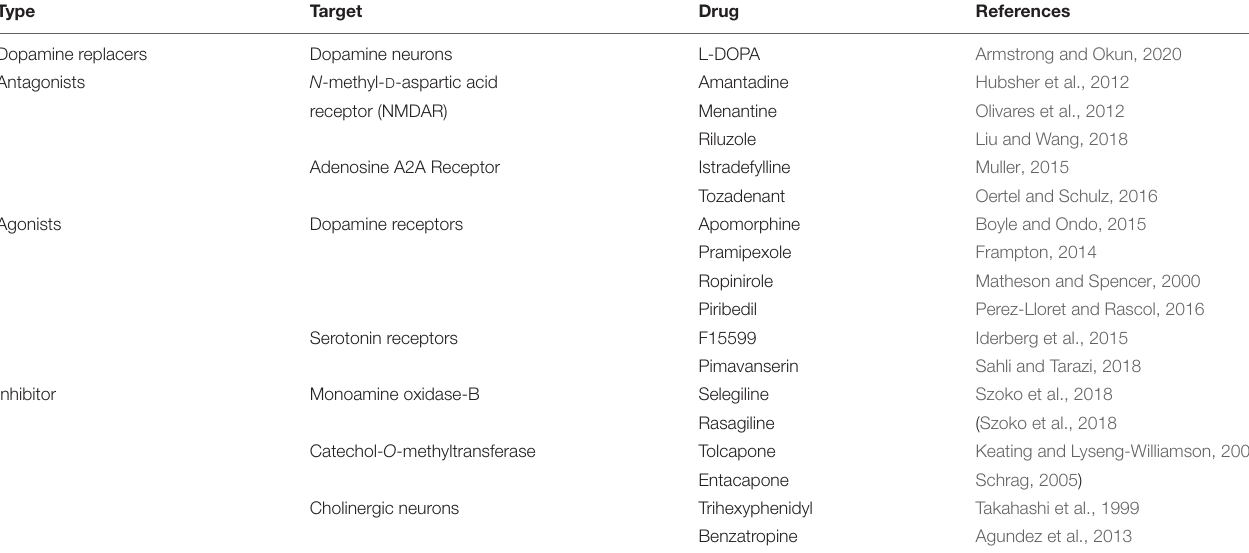
TABLE 1 | Classification of common drugs for the treatment of